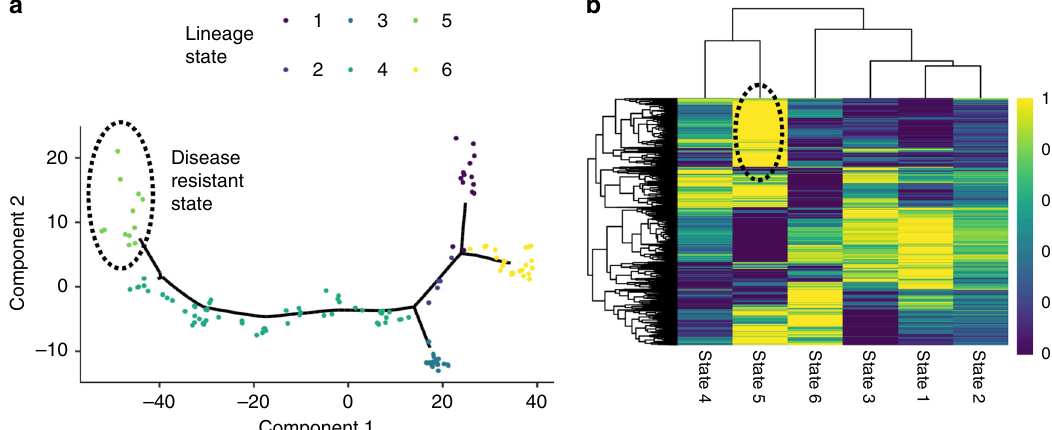
Fig. 5 Disease resistant state. a The inferred manifold from the TCX region with samples colored by their inferred disease subtype/state is shown in the left panel. State 5 (dots, circled) lies at the late end of the disease trajectory, indicating a strong disease-like transcriptomic phenotype, yet most samples in the group did not have pathologically diagnosed AD (Fig. 2a). We hypothesize this group represents a disease resistant state to the disease. b Biclustering results of average expression from each disease state, with increased expression of a gene cluster (Cluster 4) unique to State 5 is shown in the right and lysosomal storage function (Supplementary Fig. 23 and Sup- severity 40 . ADAMTS14 is part of a locus that has been previously plementary Table 7). IL7 has been proposed as an in fl ammatory biomarker for LOAD that correlates with disease outcome and